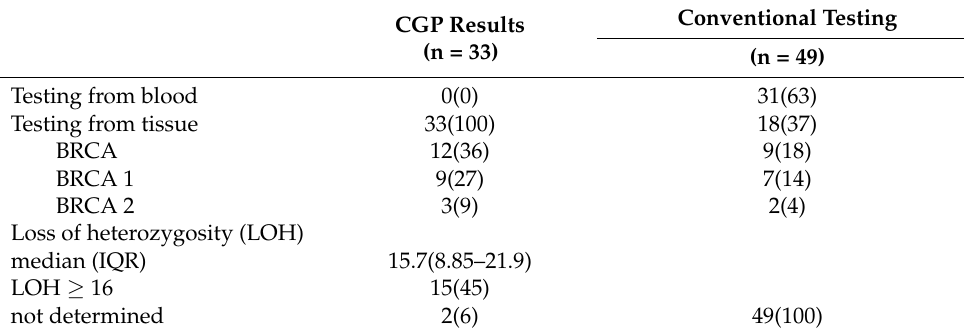
Table 4. Comprehensive genomic profiling vs. conventional testing for